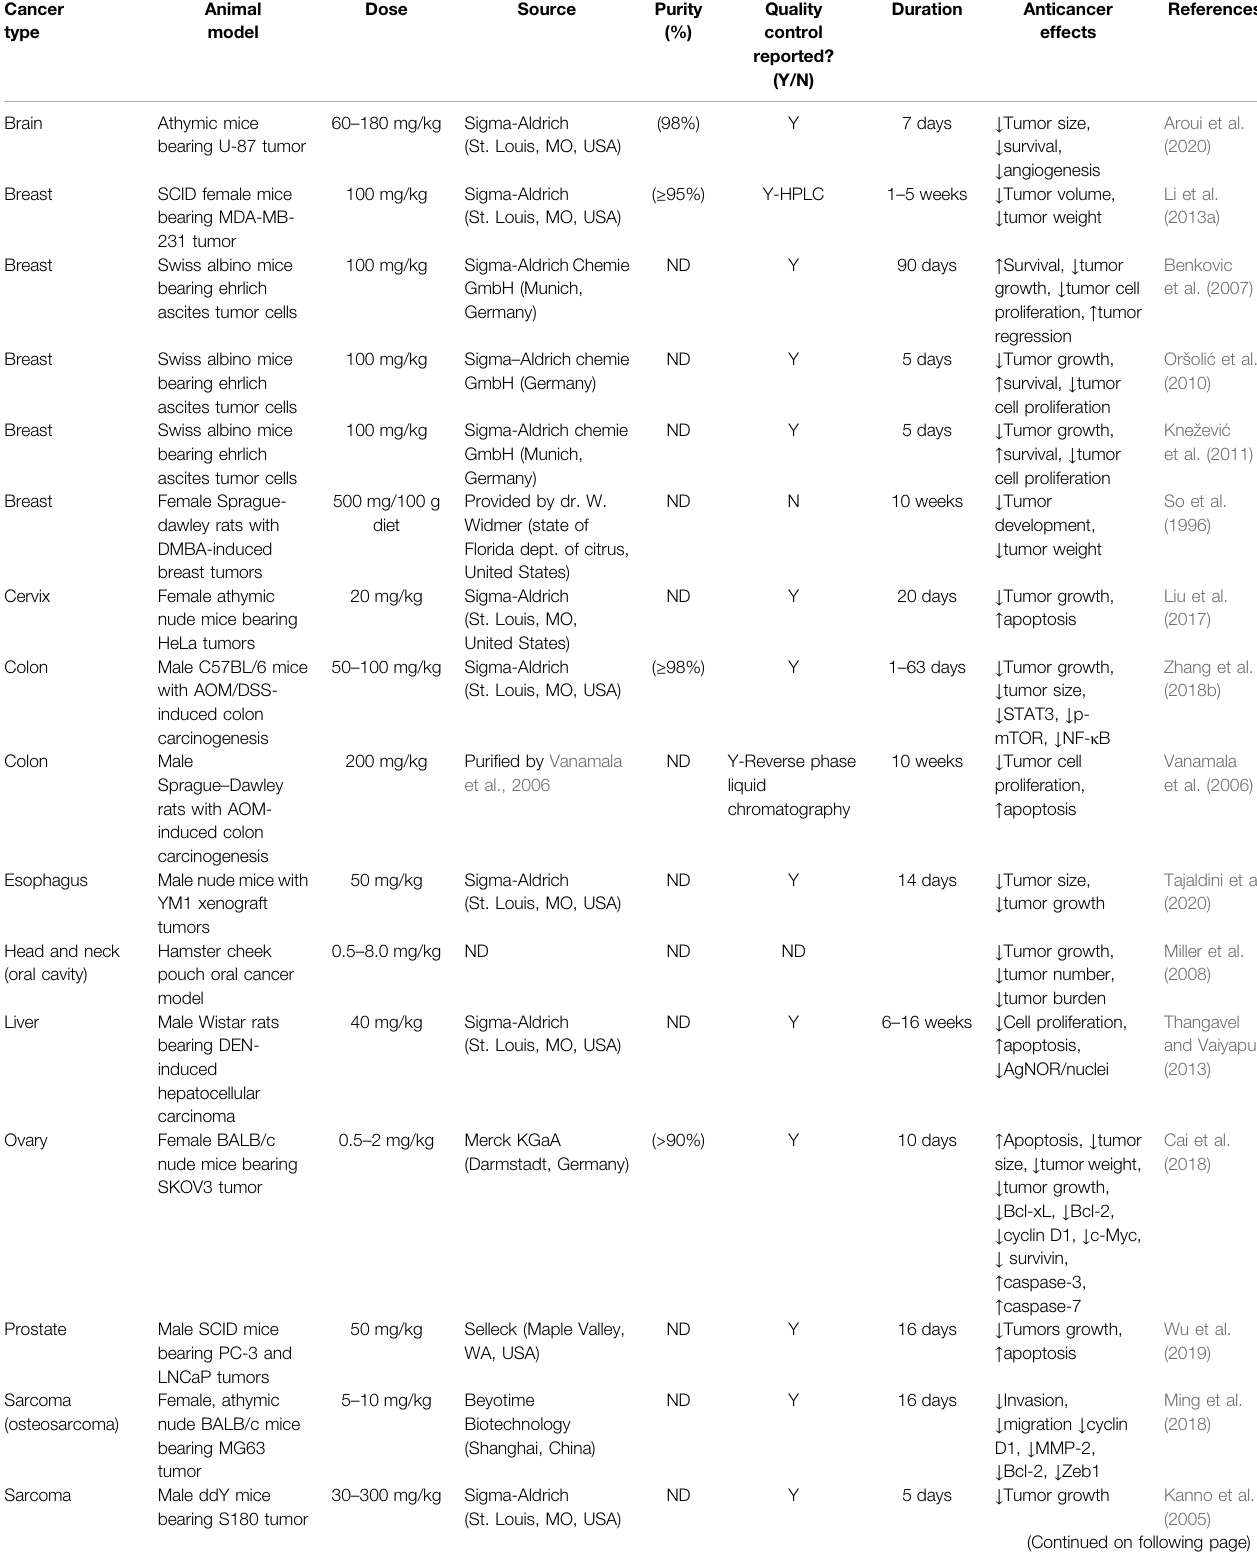
TABLE 4 | Potential anticancer effects and related mechanisms of action of naringin based on in vivo